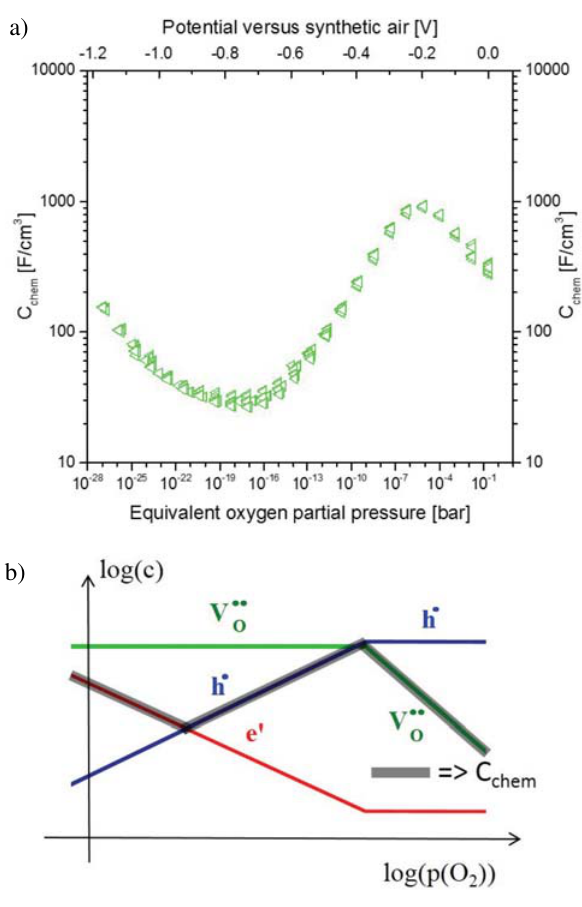
Fig. 5. (a) Chemical capacitances measured at 600 °C in air in de- pendence of the electrode overpotential (upper abscissa) and the corresponding p(O ) (bottom abscissa, calculated by Nernst’s equa- 2 is determined from the main arc of the spectra (cf. Fig. tion). C chem 4) and is normalized to the active electrode volume. (b) Sketch of a part of the Brouwer diagram in Fig. 3, indicating the partial pressu- re dependence of the minority charge carrier concentration which ; the decisive charge carrier is reflected by the grey determines C chem line in parallel to the